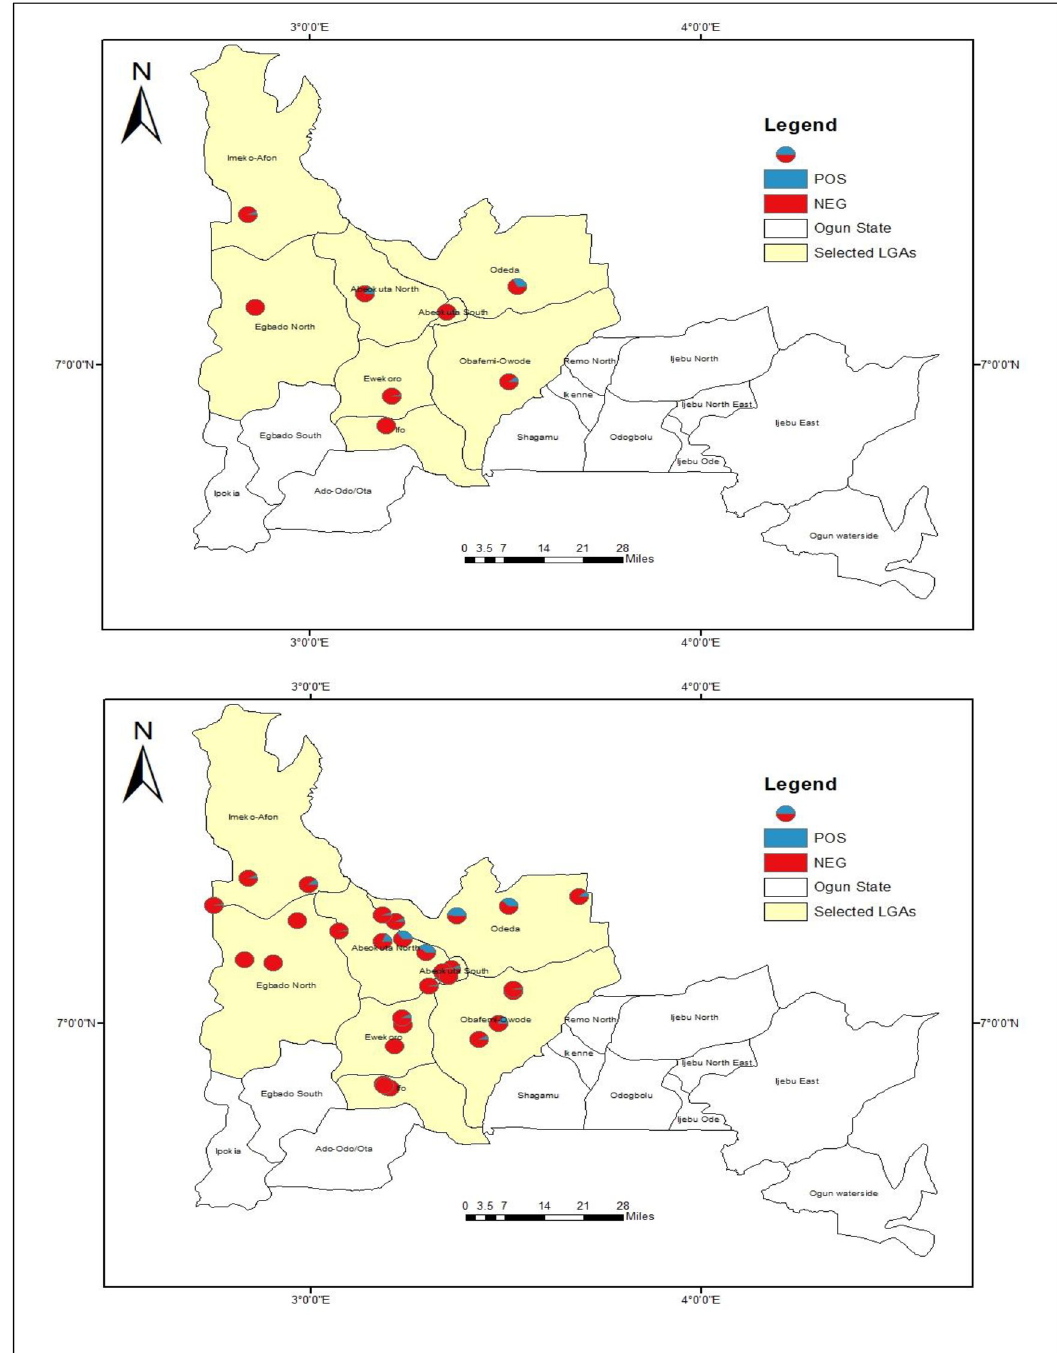
Fig 2. Geospatial distribution of onchocerciasis at LGA and community level. This figure was created by the authors in R programming software (R version 4.1.2, Vienna, Austria). Available at https://www.R-project.org/. The Nigerian shapefile was obtained from World BankDataCatalog (https://data.humdata.org/dataset/geoboundaries-admin-boundaries-for-nigeria) an Open license standardized resource of boundaries (i.e., state, county) for every country in the world.